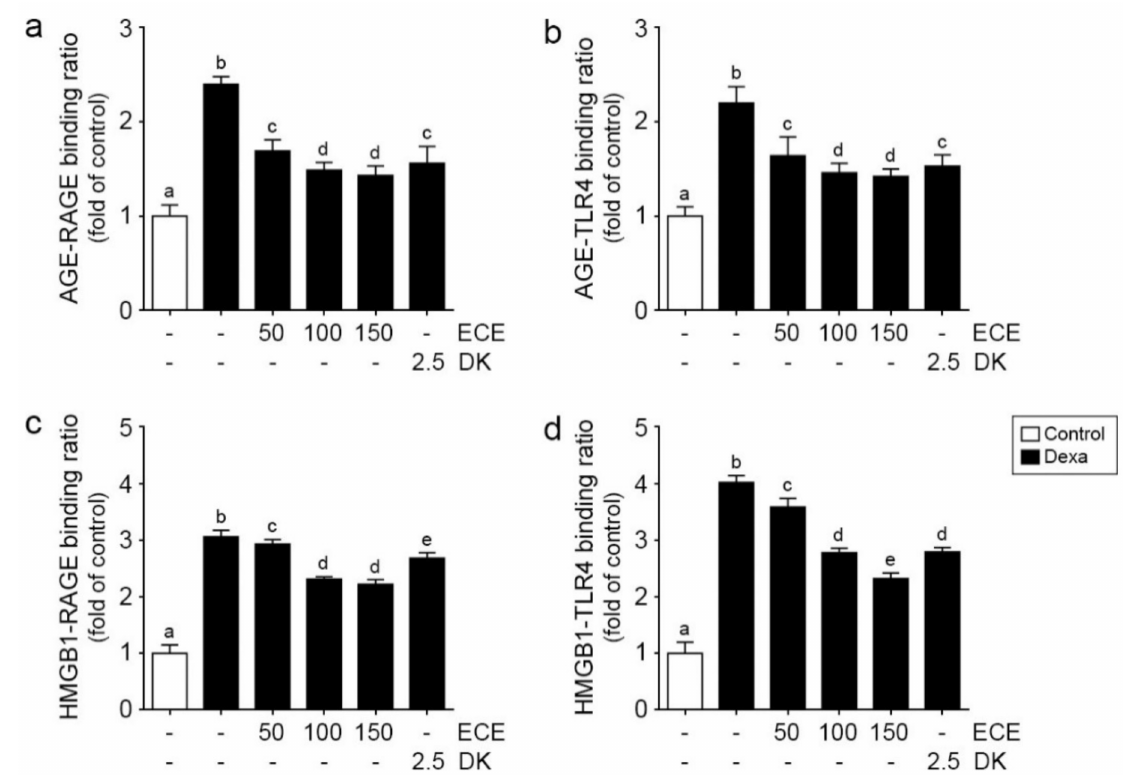
Figure 1. Inhibitory effects of ECE and DK on the relative binding levels of RAGE-AGE, RAGE-HMGB1, TLR4-AGE, and TLR4-HMGB1 in the gastrocnemius muscle of the Dexa-induced muscle atrophy model. The relative binding levels of RAGE-AGE ( a ), RAGE-HMGB1 ( b ), TLR4-AGE ( c ), and TLR4-HMGB1 ( d ) were increased by Dexa but decreased by ECE and DK treatment. The dose unit of ECE and DK is mg/kg/day. a–e: Different letters indicate significant differences among groups as determined by multiple comparison (Mann–Whitney U test); p < 0.05. AGE, advanced glycation end products; Dexa, dexamethasone; DK, dieckol; ECE, Ecklonia cava extract; HMGB1, high mobility group box 1; RAGE, receptor of AGE; TLR4, toll like receptor